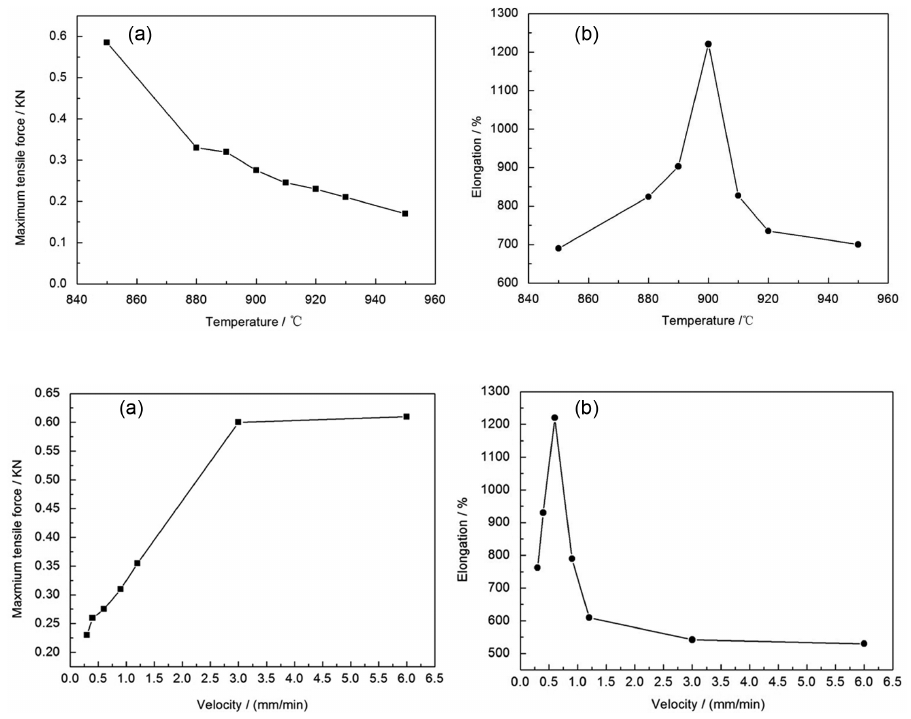
Figure 4: The tensile velocity effect on the (a) maximum force and (b)